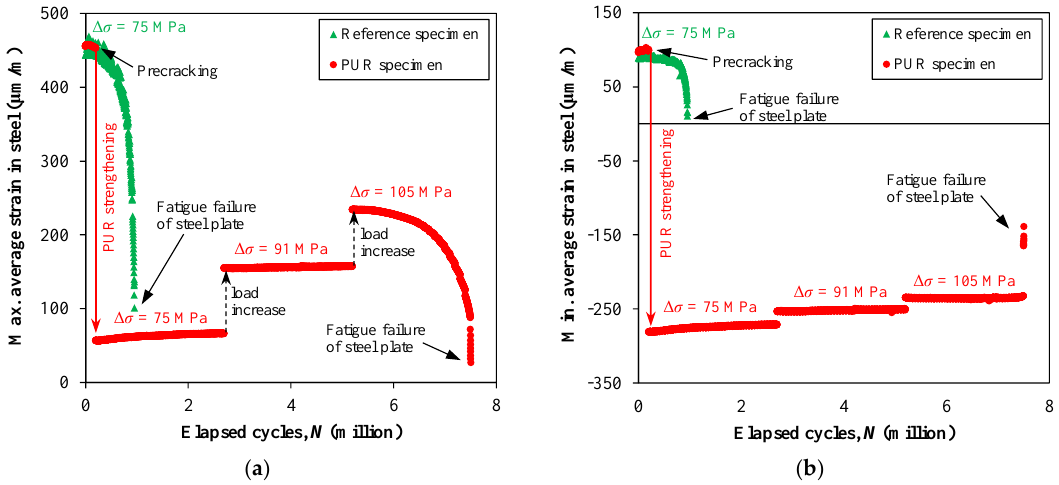
Figure 9. Evolution of: ( a ) maximum; and ( b ) minimum average strain in steel with respect to fatigue cycles (Δ σ = fatigue stress range applied to the unstrengthened cross section of steel).